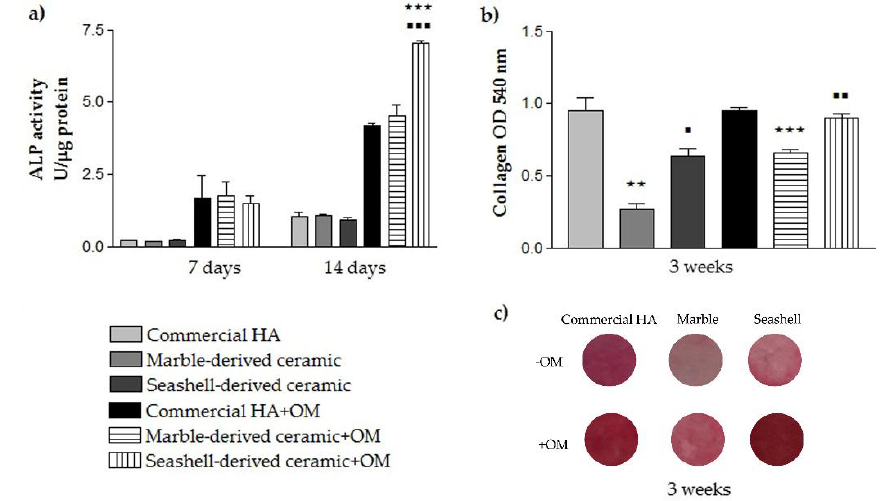
Figure 8. Results of the MC3T3-E1 cell differentiation assays showing: ( a ) the levels of intracellular ALP activity at 7 and 14 days post-seeding ( n = 3, mean ± SD). ⋆⋆⋆ p < 0.001 for seashell-derived